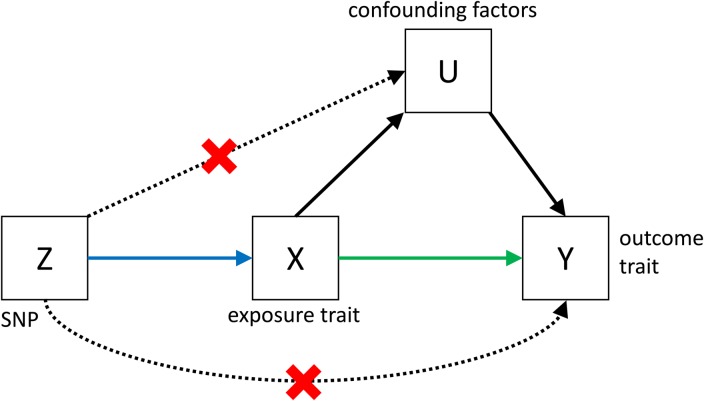
Causal pathways in an MR experiment. A causal effect of exposure (X) on outcome (Y) can be inferred if three core assumptions are met. These assumptions concern the genetic instrumental variable, Z, and state that: (i) Z has to be robustly associated with the exposure variable, (ii) Z cannot be related to any common causal factors of X and the outcome Y (these are labelled U), and (iii) Z may only be related to Y through X (Solovieff et al.
2013). The latter two assumptions can be summarised as the absence of pleiotropy for the instrumental variable.